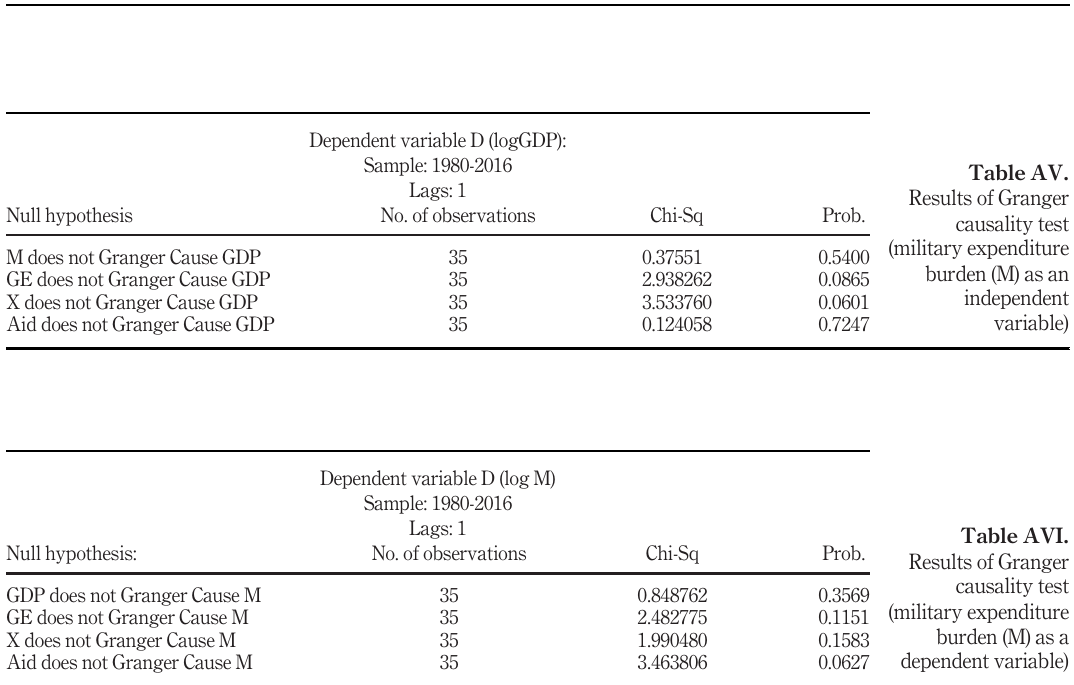
Table AIV. The results of vector-